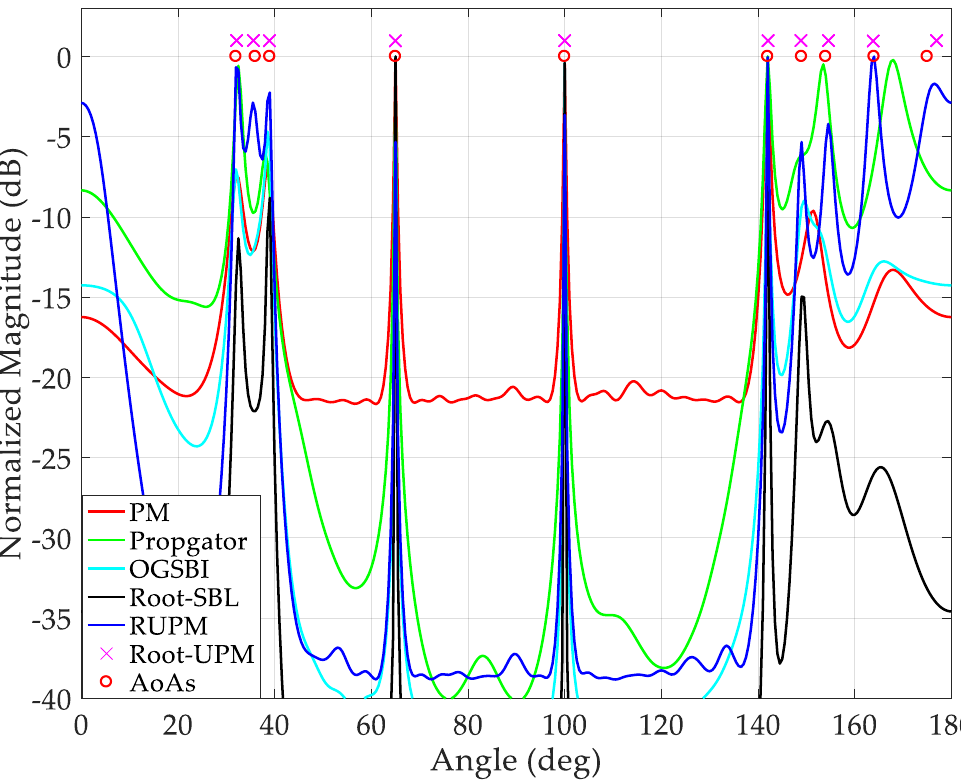
ff erent criteria with 3 AoAs close to each